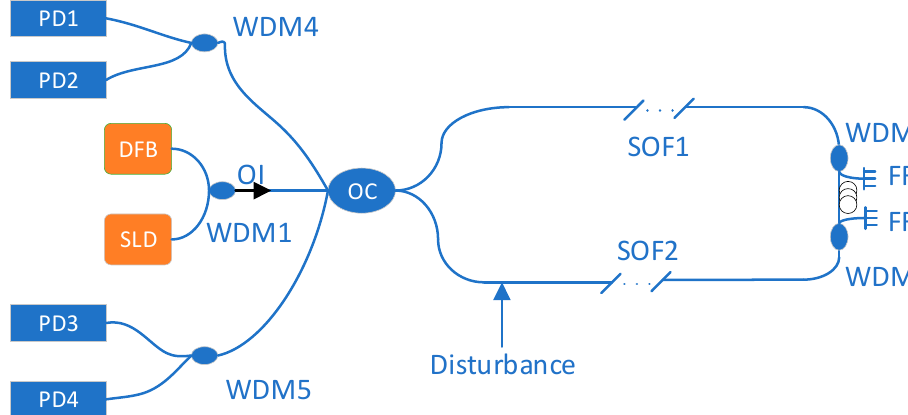
Figure 2. Michelson–Sagnac interferometric sensing system.